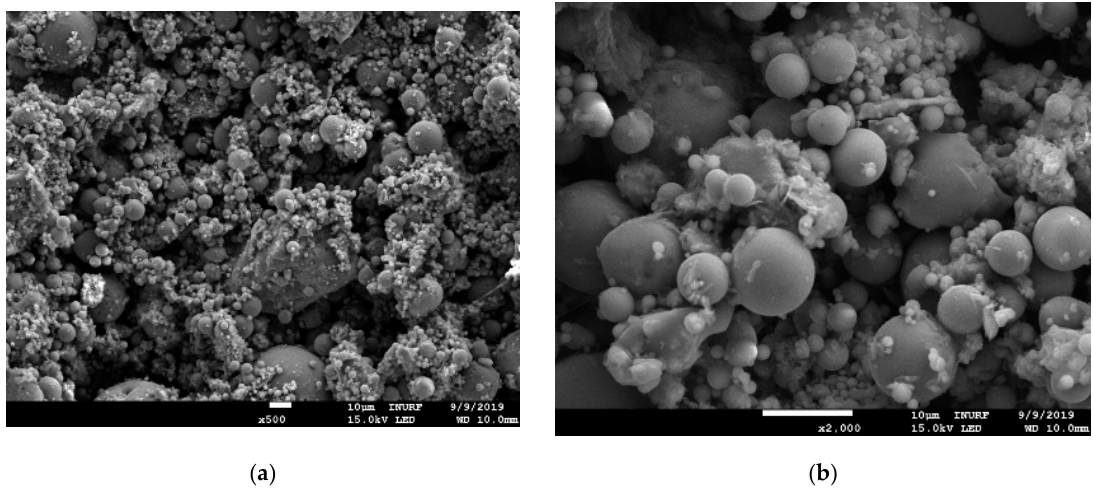
Figure 3. SEM images of fly ash: ( a ) 500×; ( b ) 2000×.